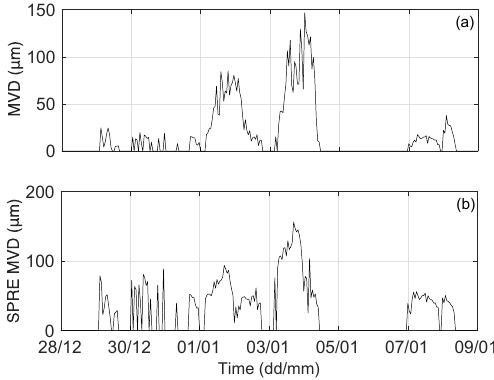
Figure 12. (a) Production forecast in MW at site A for the differ- ent approaches (Fig. 3). For CMngb, ENSngb and ENS the lines present the average of the multiple forecasts. Observed production is given with the dash-dotted line. The production is calculated for a 2MW turbine. (b) The spread of the multiple members in CMngb, ENSngb and